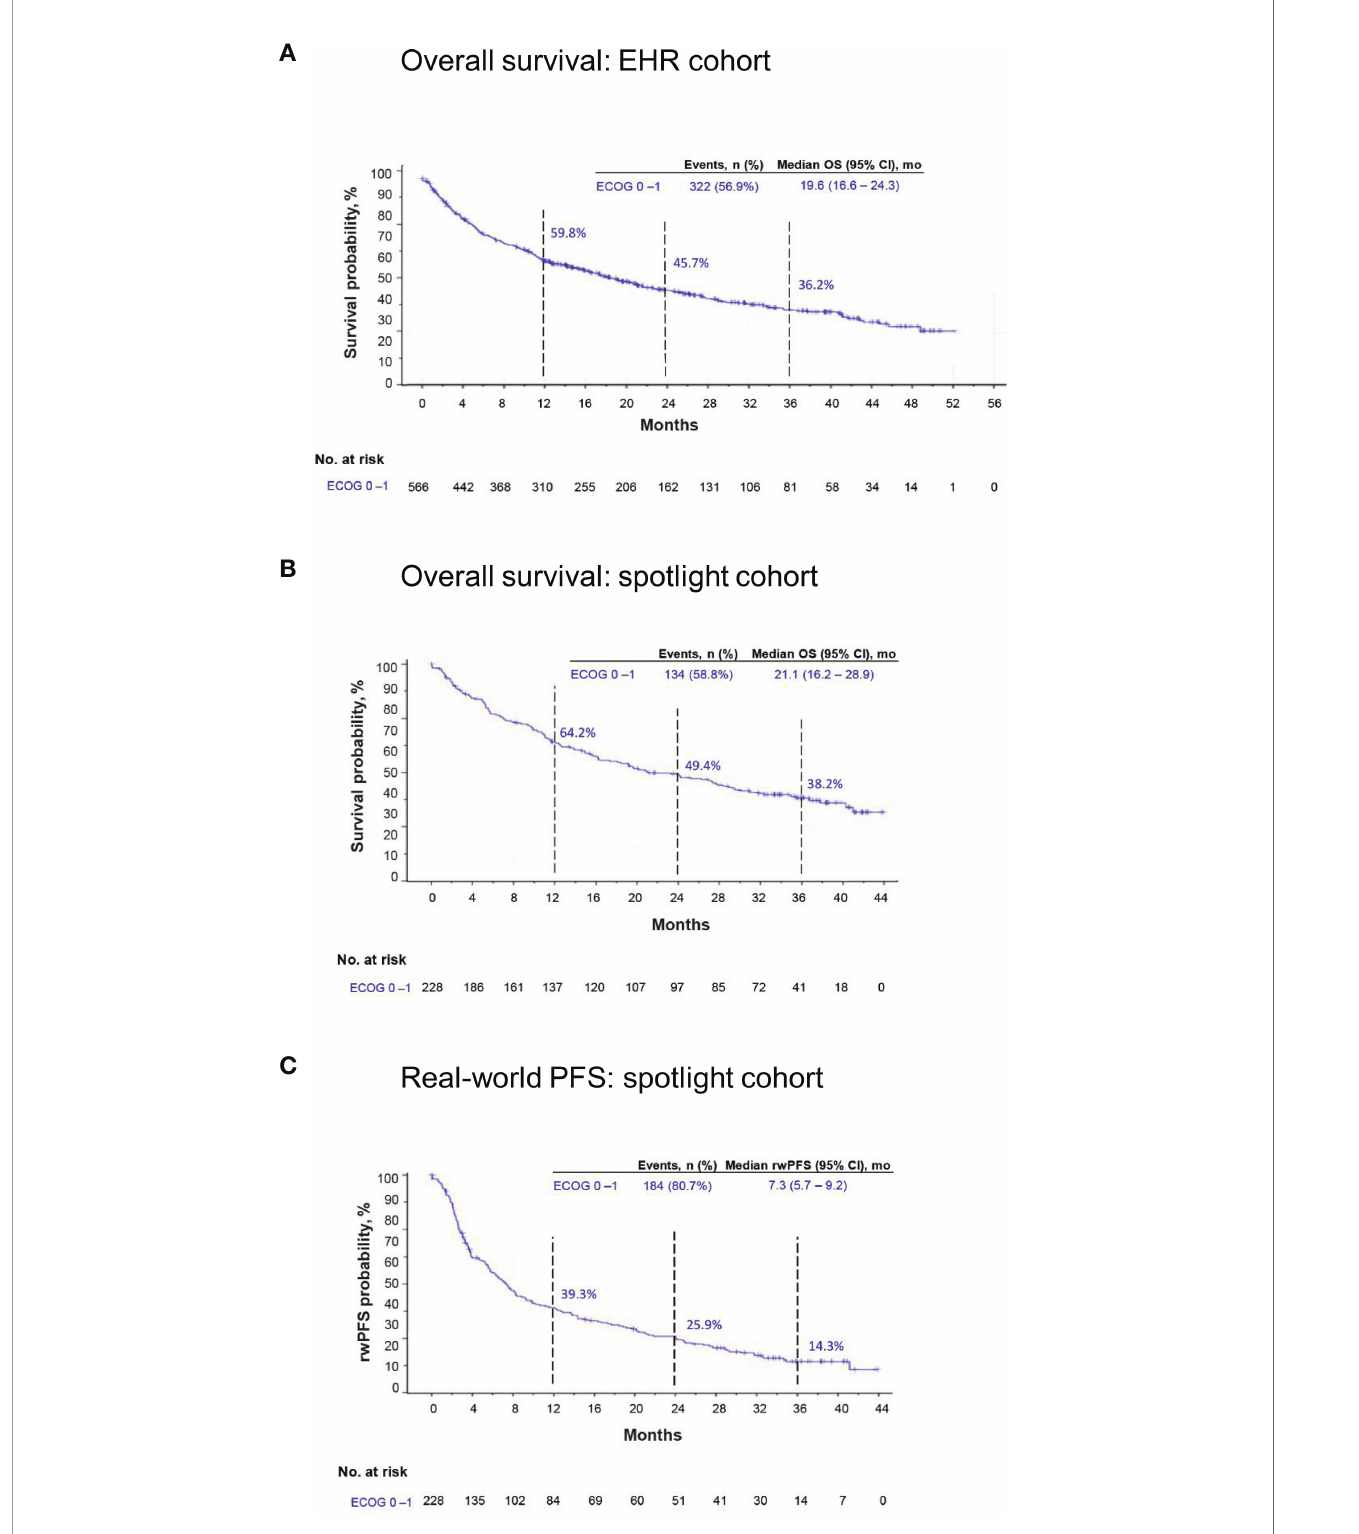
FIGURE 3 | Kaplan-Meier estimates of overall survival (OS) in the EHR and spotlight cohorts and real-world progression-free survival (rwPFS) in the spotlight cohort.EHR, electronic health record; mo, months. (A) OS in the EHR cohort. (B) OS in the spotlight cohort. (C) rwPFS in the spotlight